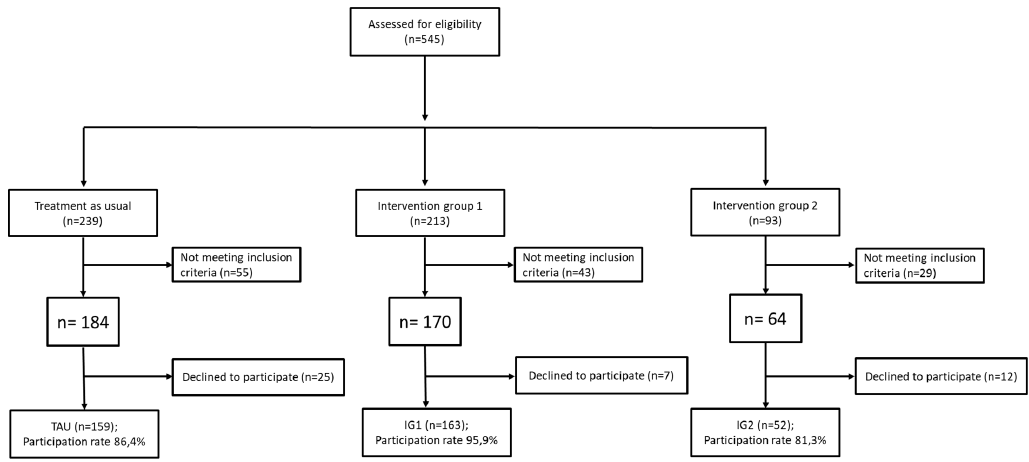
Figure 2. Trial flow chart describing the recruitment process of all three study arms .